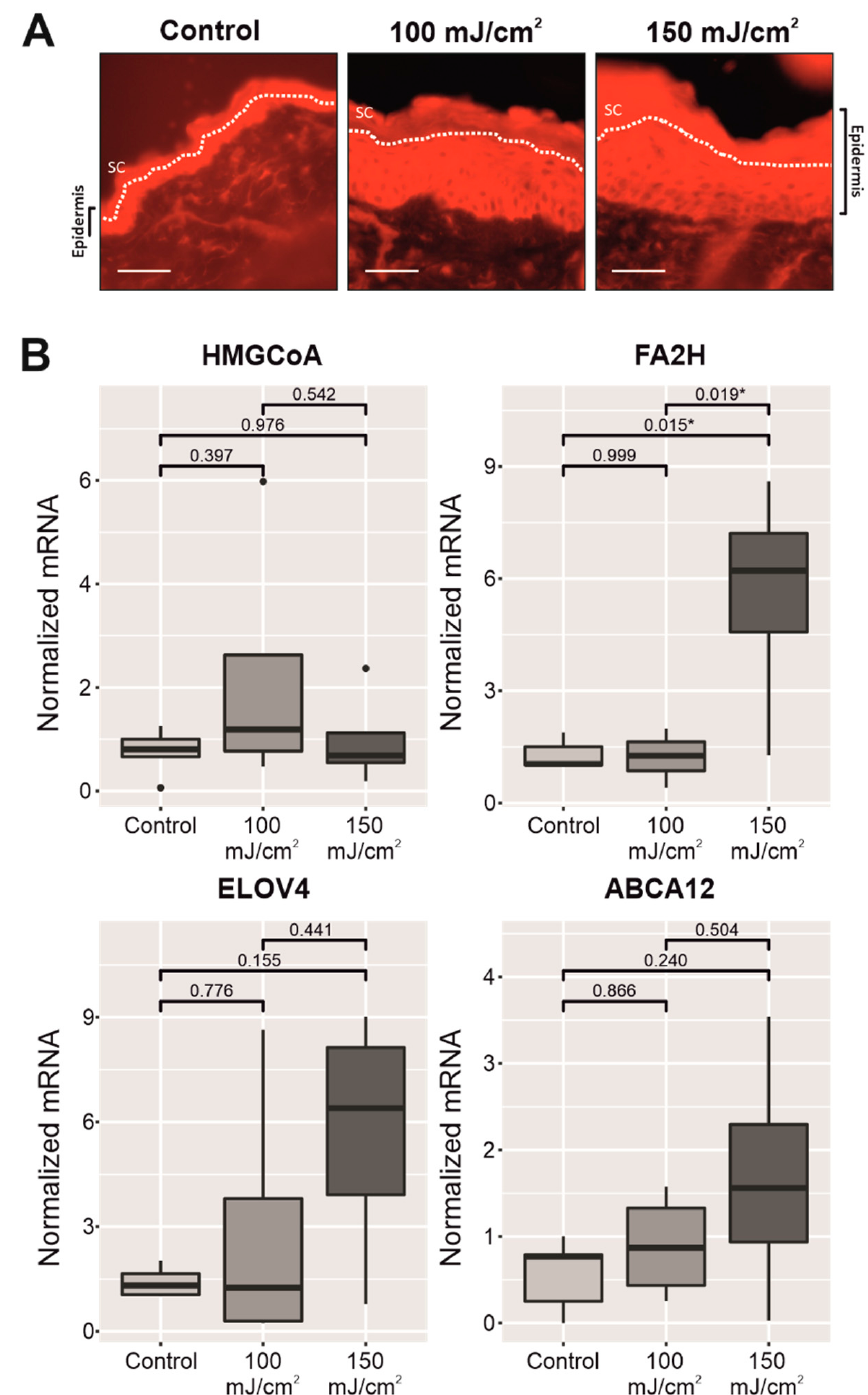
Figure A3. Comparative Nile red staining of skin samples from nonirradiated skin with respect to the UV-B-irradiated skin with CFC of the mouse back at the end of the experiment (14 weeks after initiating UV-B irradiation), showing more fluorescent dye uptake within the epidermis and, especially, in the outermost layers of the epidermis. SC = stratum corneum. The scale bar represents 100 µ m ( A ). Below, we give the mRNA expression levels of lipid enzymes HMGCoA reductase, FA2H, ELOVL4, and lipid transporter ABCA12, linked to the permeability barrier in UV-B-irradiated skin, 100 and 150 mJ/cm 2 , with respect to the nonirradiated group ( B ). Data are expressed as means ± SD of five experiments in each group. * p -values are indicated in the figure and marked with an asterisk when significant, p < 0.05 (Kruskal–Wallis test with Scheffe post hoc test).